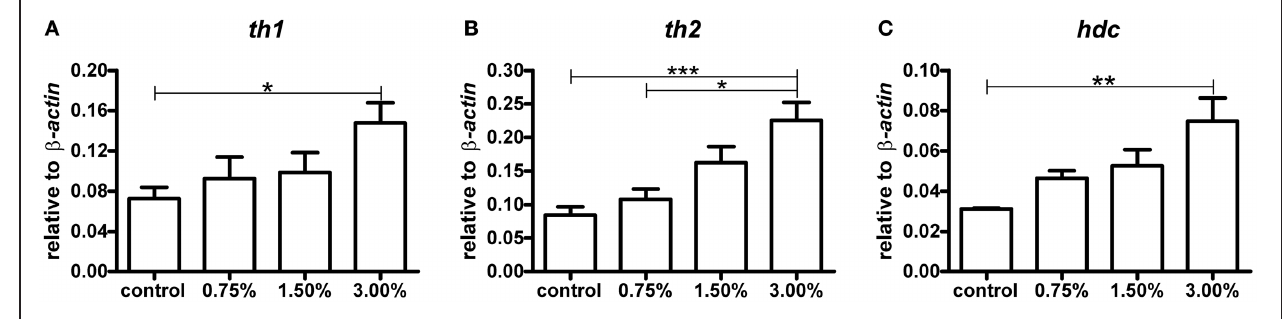
F ( 3 , 17 ) = 3 . 439, P = 0.0405; (B) F ( 3 , 17 ) = 8 . 489, P = 0.0011; (C) F ( 3 , 17 ) = 5 . 515, P = 0.0079, ∗ p < 0 . 05, ∗∗ p < 0 . 01, ∗∗∗ p < 0 . 001 according to the post-hoc test. N = 6 except for the 0.75% group, for which N = 3.